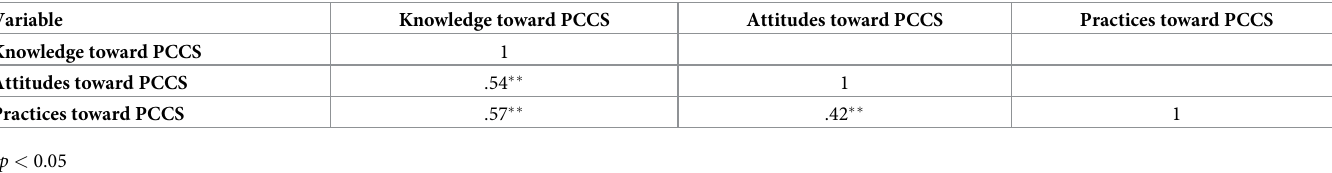
Table 3. Correlational Analysis of Knowledge, Attitudes, and Practices toward